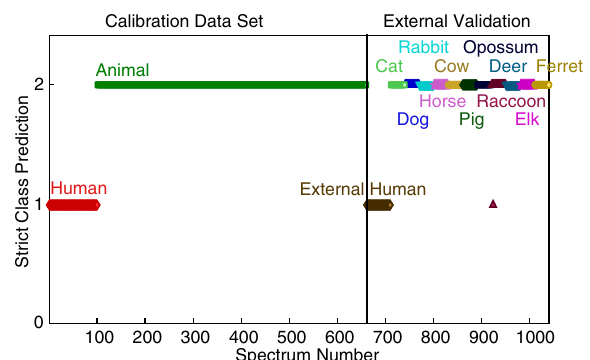
Fig. 4 Strict class prediction results by the human – animal PLSDA model with six latent variables for blood samples. Human blood spectra (red diamonds) are assigned a value of 1 and animal blood spectra (green squares) are assigned a value of 2. All spectra of external samples are on the right side of the plot (spectra numbers 661 –